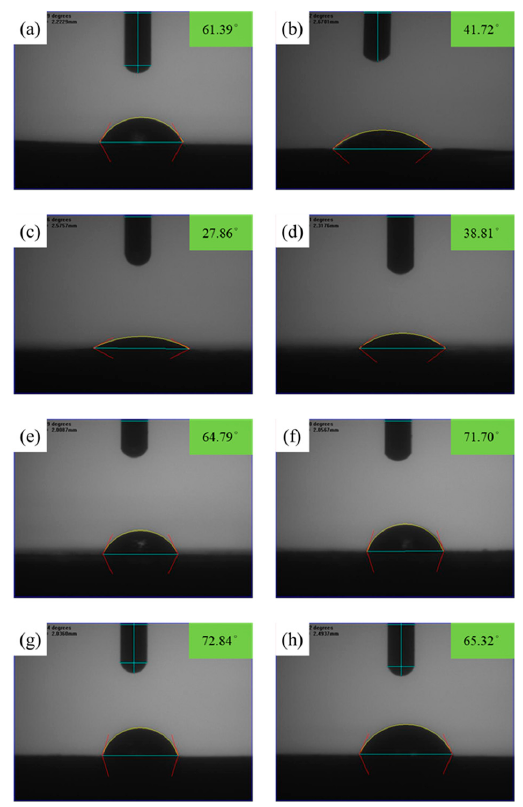
Figure 6. Photographs and calculation of contact angle of ( a ) PVA, ( b ) PVA/SA, ( c ) PVA/SA/GO, ( d ) PVA/SA/GO/ZnO nanofibers, GA-treated PVA/SA/GO/ZnO nanofibers with different crosslinking reaction times: ( e ) 12 h, ( f ) 24 h, ( g ) 48 h, and ( h ) 72 h.